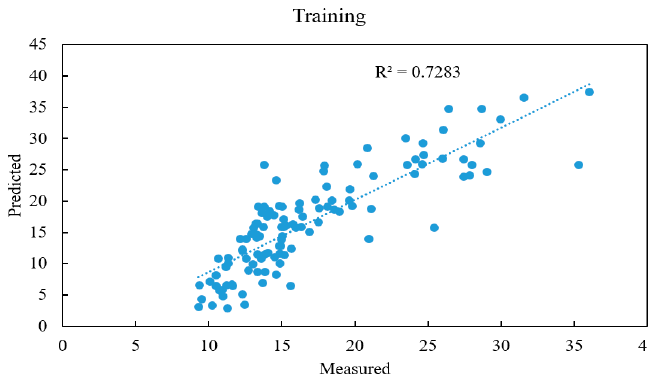
Figure 3. Training results of Equation (6) for prediction of PPV.